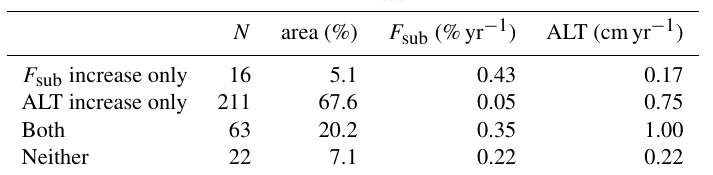
Table 3. Number of grid cells, associated area fraction of domain, and average ALT and F sub for each category shown. Study domain consists of 312 grid cells spanning an area of 196060km 2 (Fig. 1). Number of grids, area, and ALT and F sub averages for each subregion.